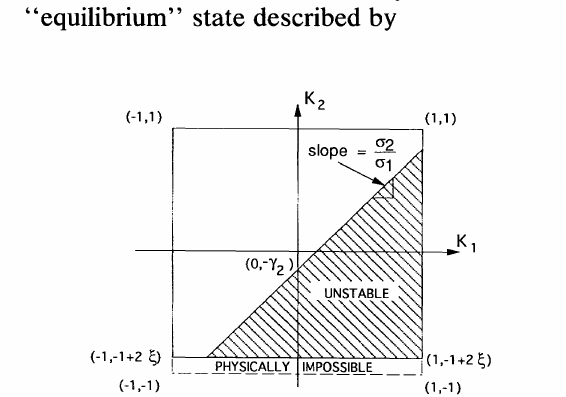
FIGURE 6 Second instability chart for the